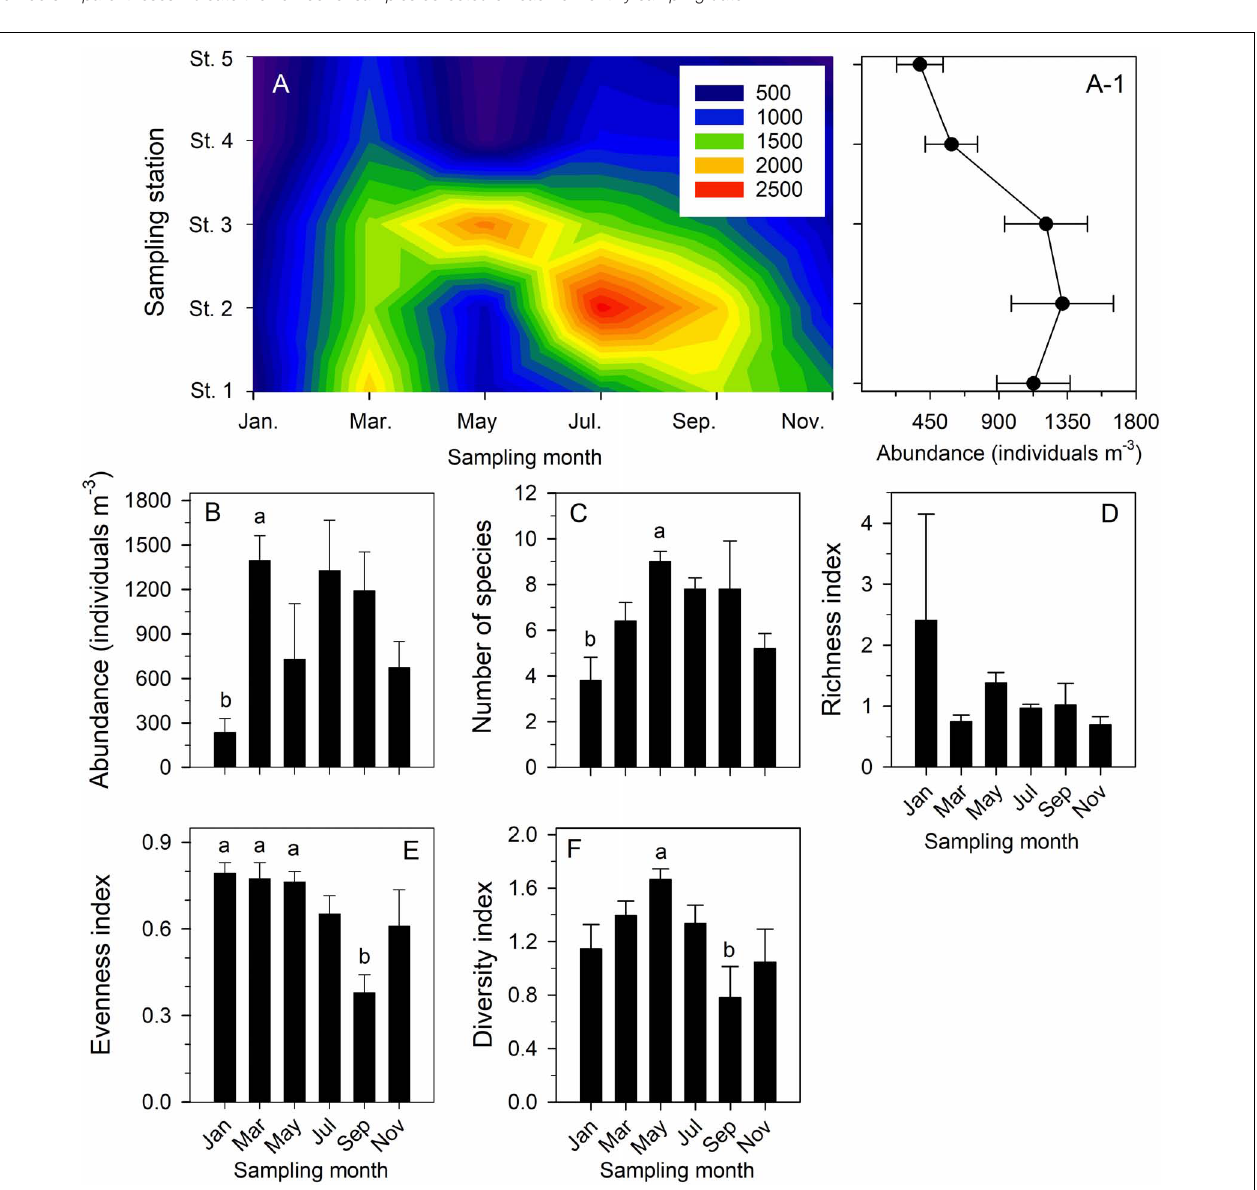
FIGURE 7 | Contour chart showing temporal variation in total copepod abundance (individuals m − 3 ) of six bimonthly sample series taken in Danshuei River estuary in 2014 (A) ; mean abundance ( ± standard deviation) of total copepod abundance at each sampling station during all six bimonthly sampling cruises (A-1) ; and comparisons of bimonthly changes in mean ( ± standard deviation) abundance (B) , number of species (C) , and indices of richness (D) , evenness (E) , and Shannon–Wiener diversity (F) over the year at all stations. Various superscripts indicate significant differences ( p < 0.05) confirmed by one-way analyses of variance, followed by Tukey